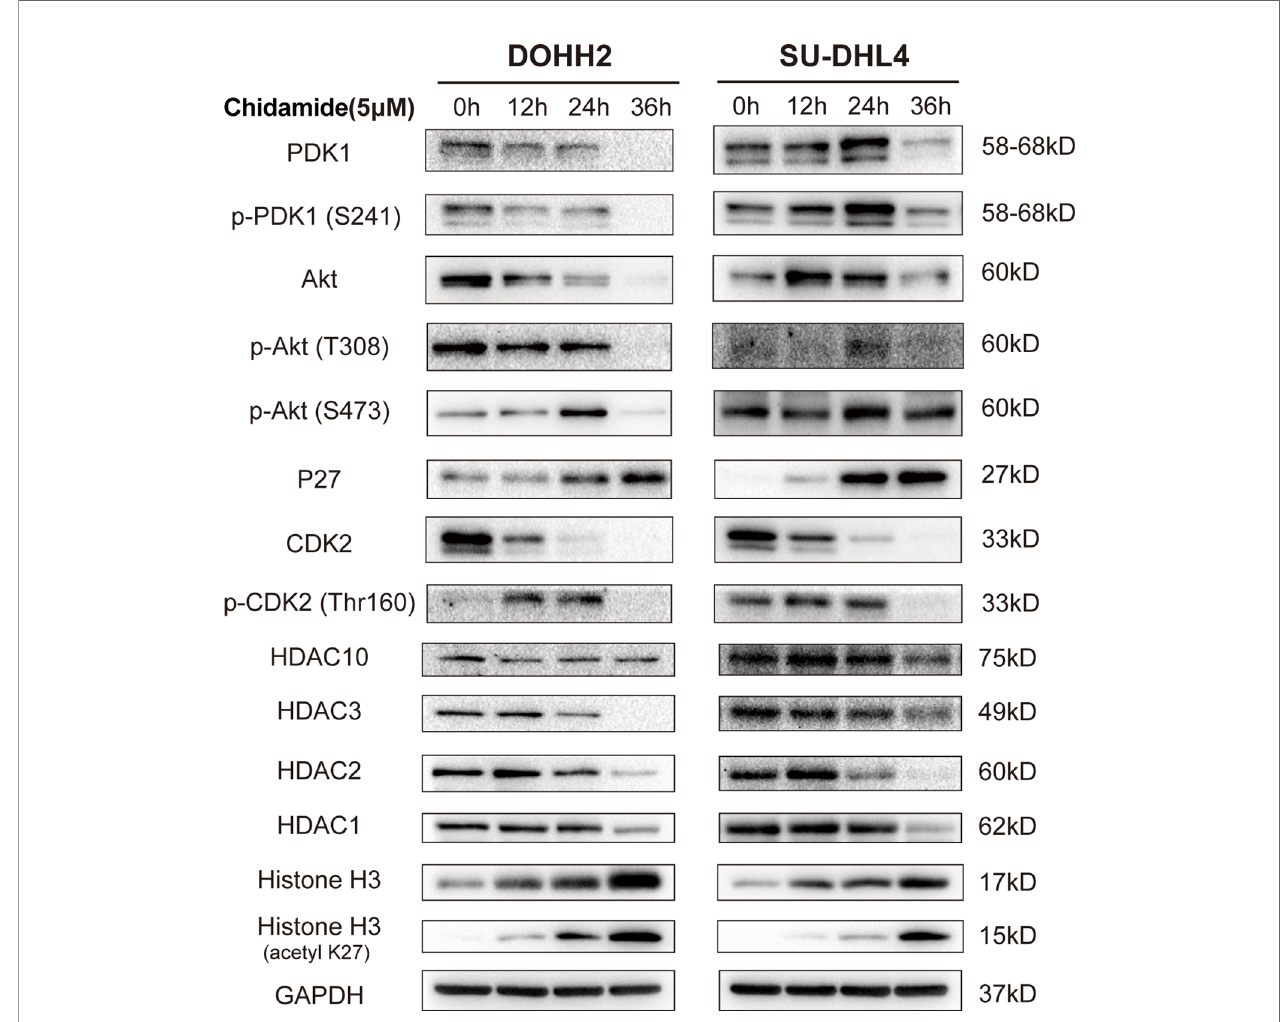
FIGURE 6 | Differential gene and protein expression in FL cells after chidamide treatment. DOHH2 and SU-DHL4 cells were treated with 5 m M chidamide for the indicated times. The levels of differential genes were determined by Western